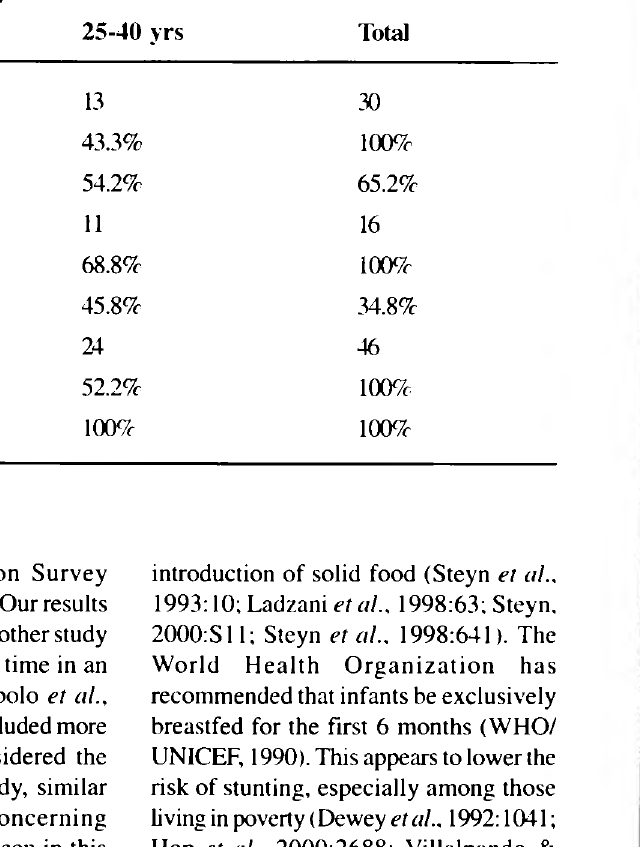
Table 4. Data on breastfeeding practices of the Dikgale women